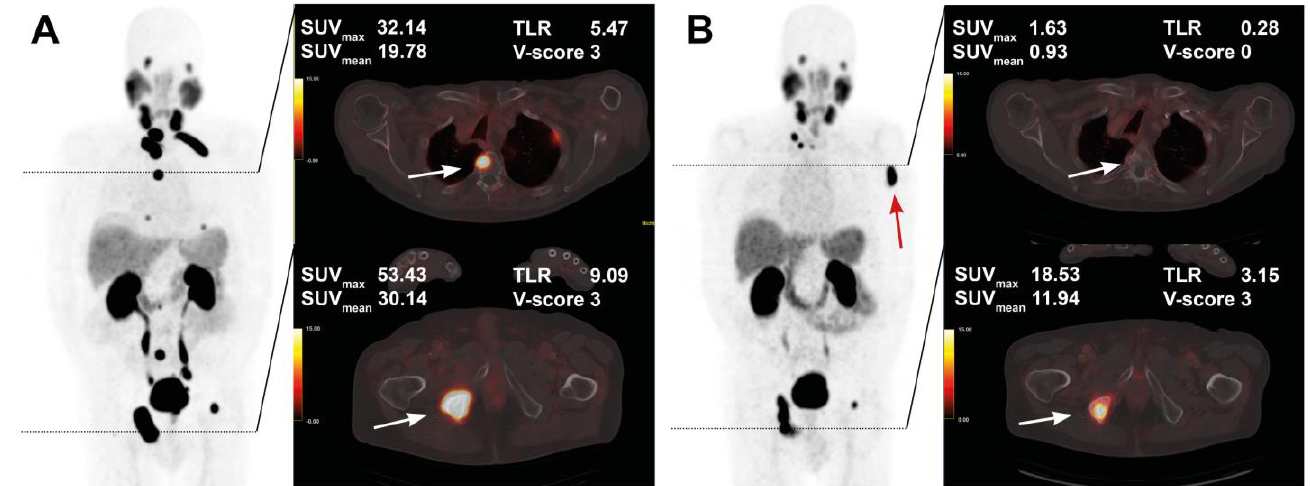
Figure 5. Pre- and post-treatment images in an 83-year-old patient after 5 cycles of RLT with cumu- lative 35.1 GBq [ 177 Lu]Lu-PSMA-617. Maximum intensity projection (MIP) images (left) with cross- section fusion images in a thoracic and pelvic plane at baseline ( A ) and after RLT ( B ). Lesions (white arrows) with intense baseline uptake showing response to RLT; a new bone metastasis develops in the left humerus (red arrow).